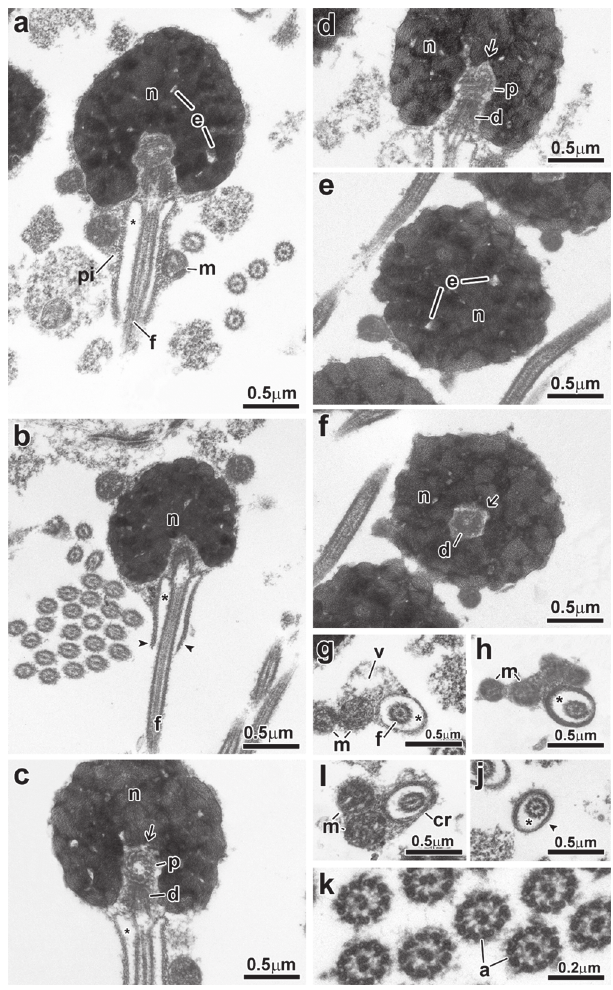
Fig. 5. Spermatozoon of Brycinus imberi . a, b, c, d: longitudinal sections. e, f, g, h, i, j, k: transverse sections from top to posterior region. The nucleus (n) is spherical and lies medial to the flagellum (f). The centriolar complex (p, d) and nuclear fossa (arrow) is medial. The proximal centriole (p) is in a right angle relative to the distal centriole (d). The cytoplasmic canal is present (asterisk). The midpiece (pi) is asymmetrical, and contains the spherical mitochondria (m), vesicles (v) and a cytoplasmic sleeve (arrowhead). Legends: a: axoneme, cr: concentric membranous rings, d: distal centriole, e: electron- lucent areas, f: flagellum, m: mitochondria, n: nucleus, p: proximal centriole, v: vesicle, asterisk: cytoplasmic canal, arrow: nuclear fossa, arrowhead: cytoplasmic